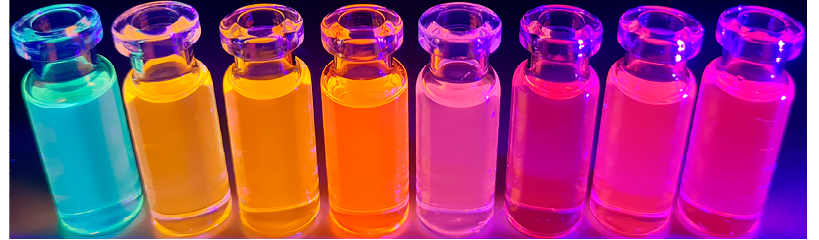
Figure 3. Compound 2 under ultraviolet light in organic solvents (hexane, benzene, ethyl acetate, chloroform, acetone, ethanol, DMF, and DMSO).